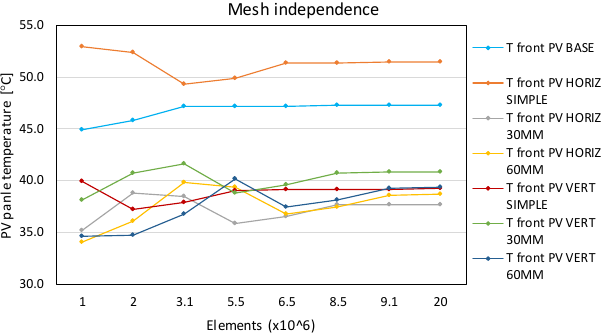
Figure 2. Mesh independence study for each model.